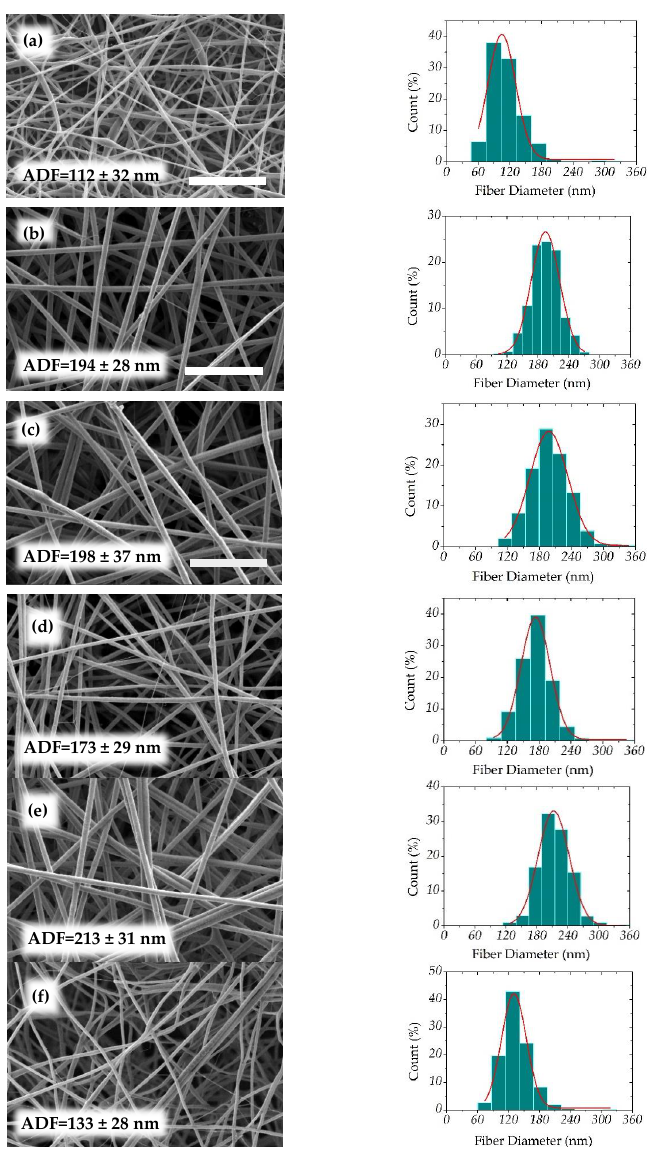
Figure 13. Scanning electron microscopy images of nanofibers obtained at different charge ratios and corresponding average fiber diameters (AFD) (nm) together with their diameter distribution. ( a ) R c = 0.5, ( b ) R c = 1.0, ( c ) R c = 1.8, (d ) R c = 2.35, ( e ) R c = 3.0, and ( f ) CS. Scale bar = 3 m.